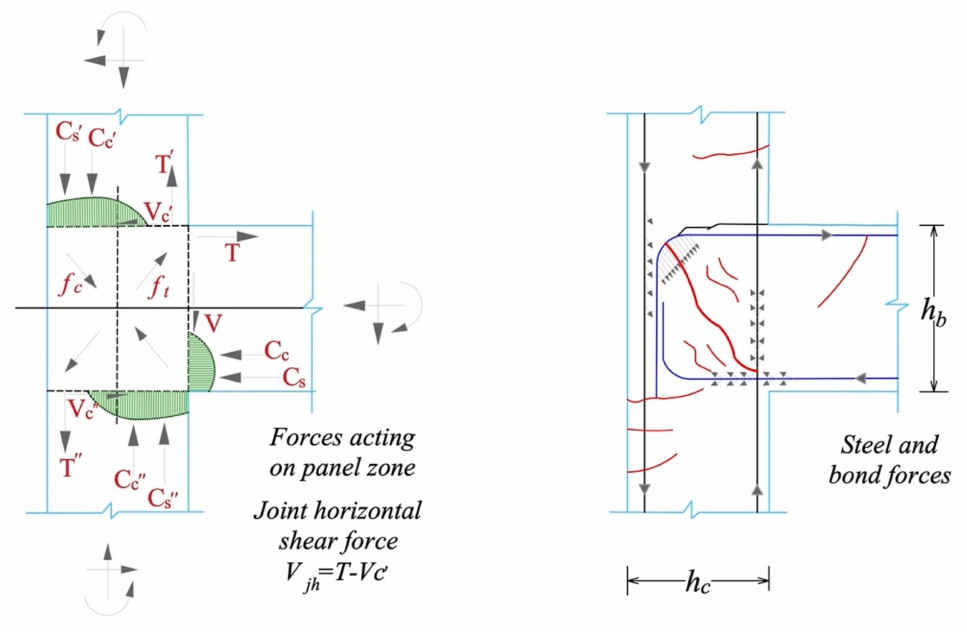
Figure 4. Principal stresses developed in the joint core, and the resulting cracking of the joint, bond, and bearing forces developed after the initiation of diagonal